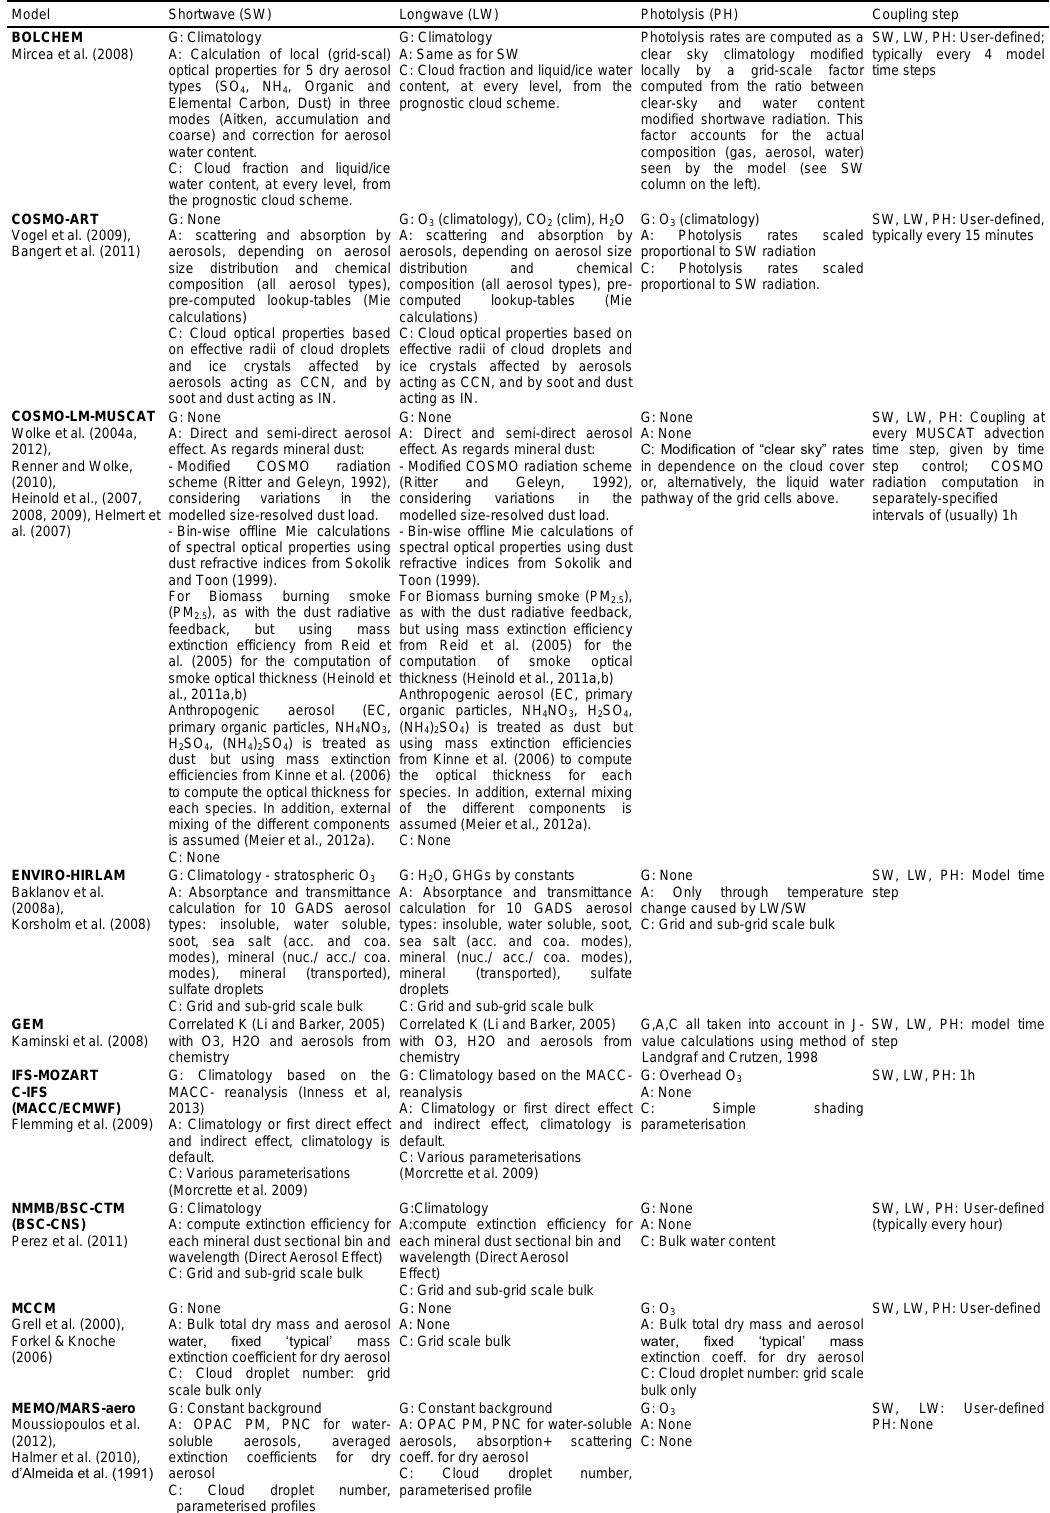
Table 8. Radiative schemes (including shortwave, longwave and photolysis modules which are considering gas [G], aerosol [A] and cloud water [C] effects) and ways of their coupling in selected online coupled models. Model Shortwave (SW) Longwave